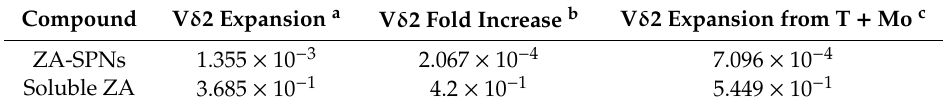
Table 1. In vitro e ff ect (EC 50 ) of ZA-SPNs and soluble ZA on V δ 2 T lymphocyte expansion. Compound V δ 2 Expansion a V δ 2 Fold Increase b V δ 2 Expansion from T + Mo c ZA-SPNs 1.355 × 10 −